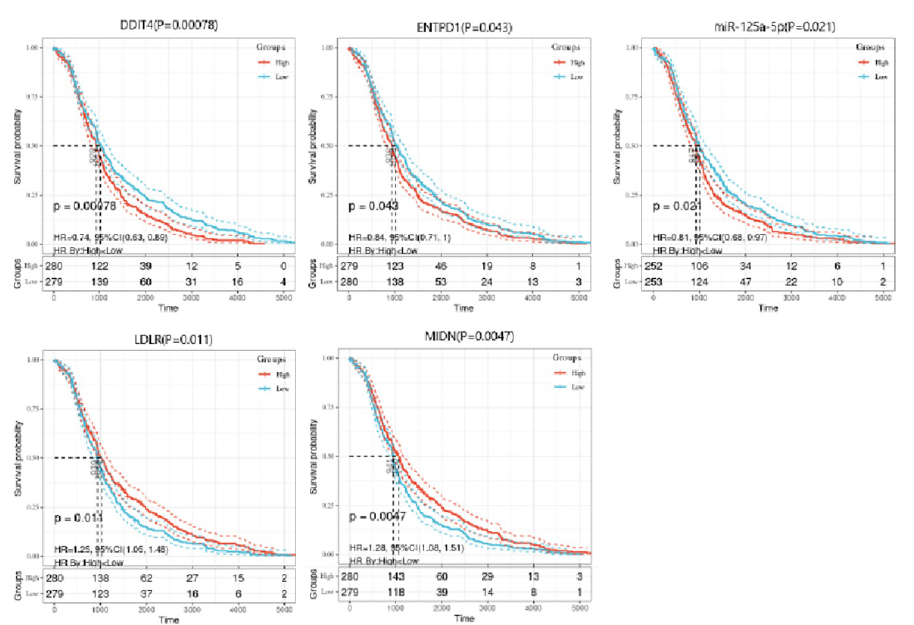
Fig 8. Survival curve of 4 mRNA and 1 miRNA.